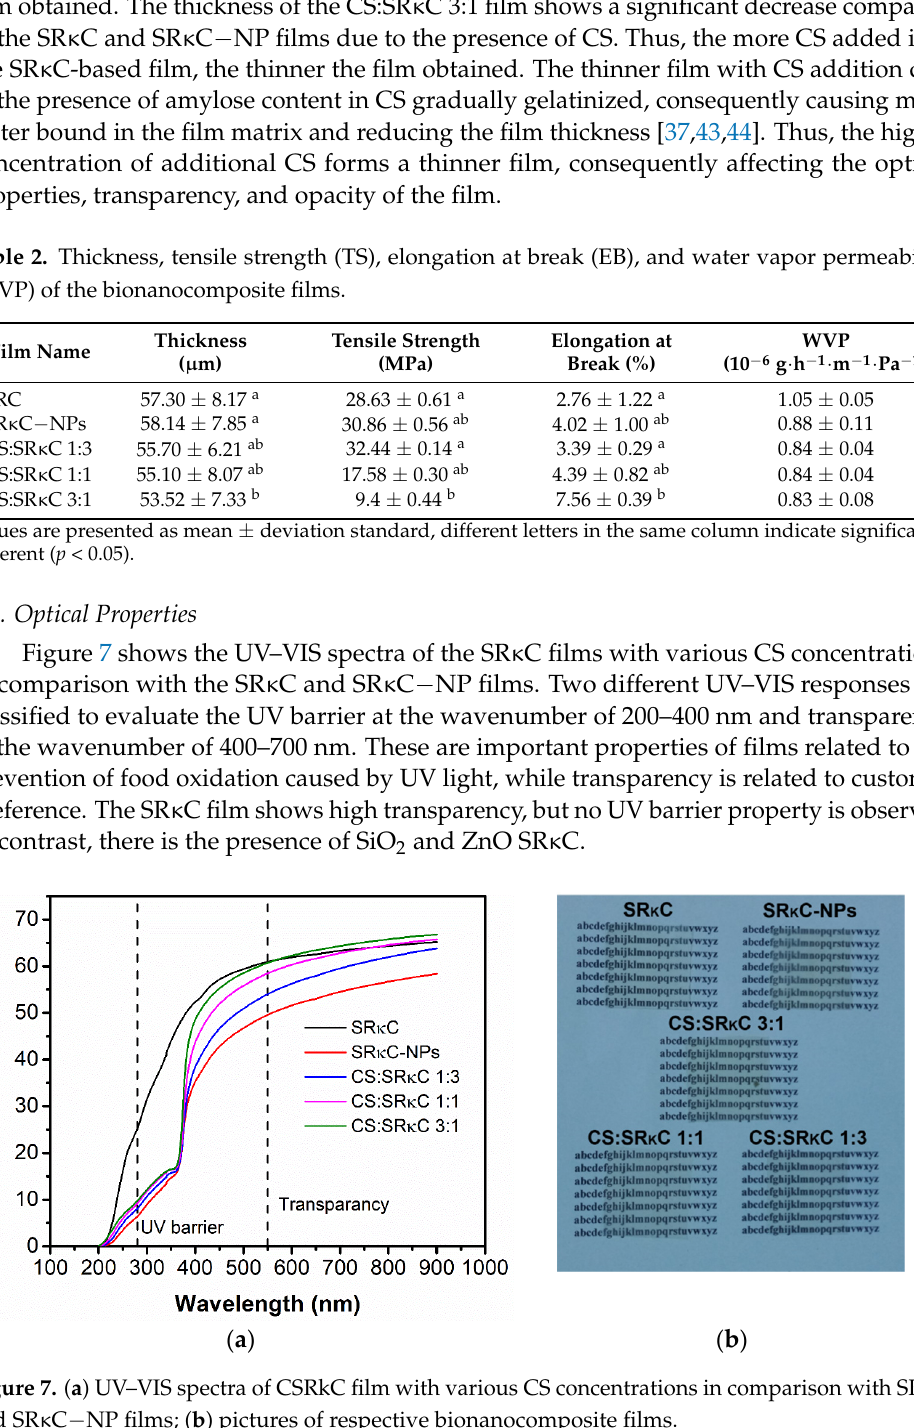
Table 2. Thickness, tensile strength (TS), elongation at break (EB), and water vapor permeability (WVP) of the bionanocomposite films.